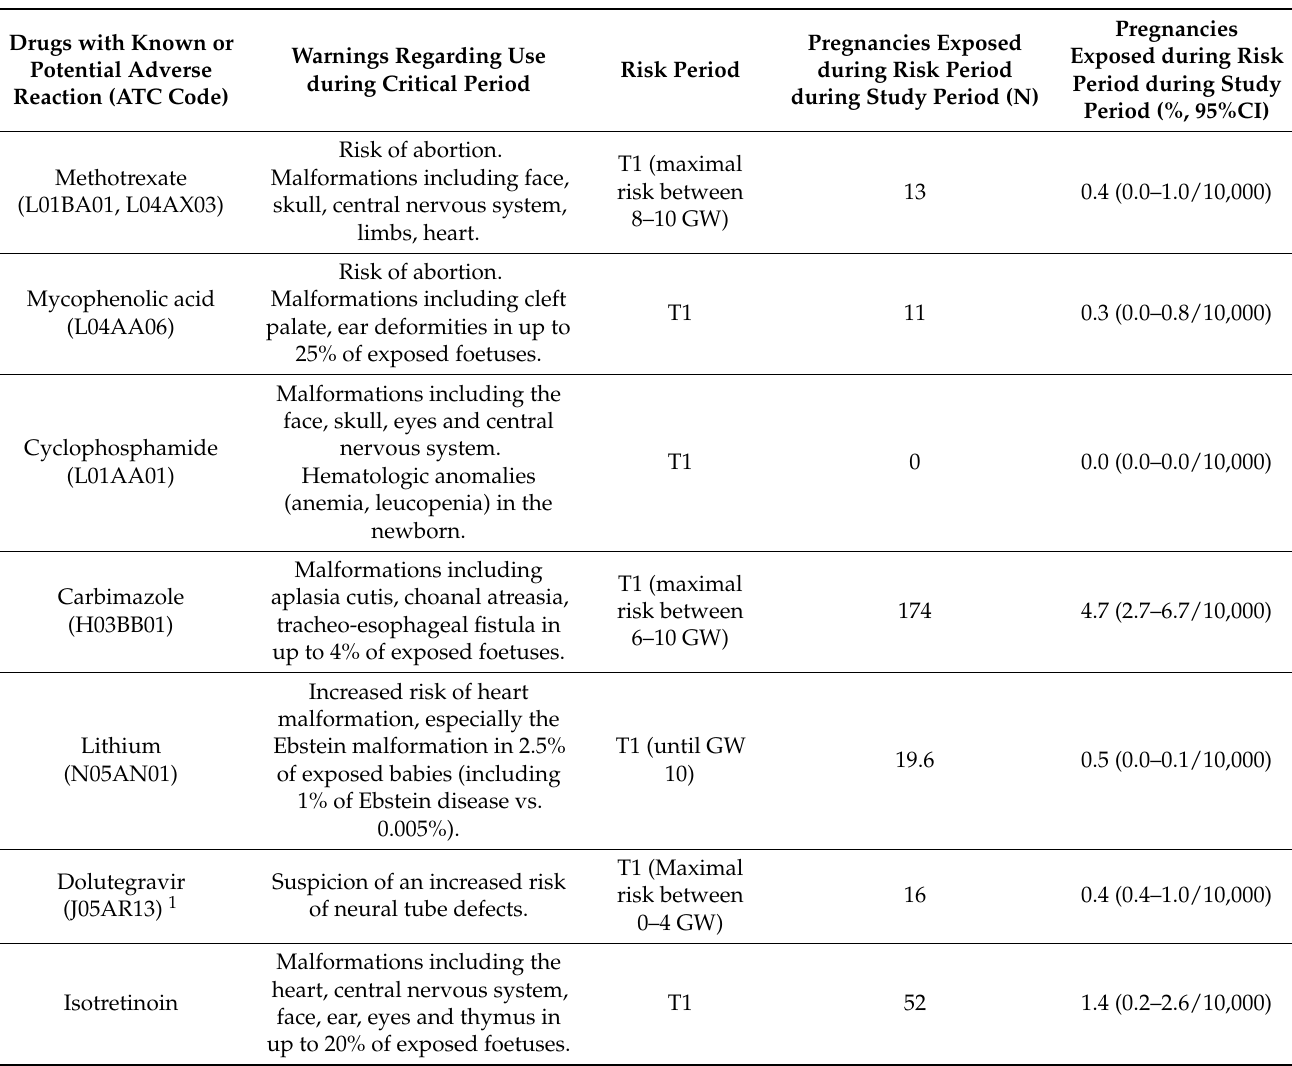
Table 3. Exposure to drugs with known or potential adverse reaction during trimester 1 (weighted numbers).